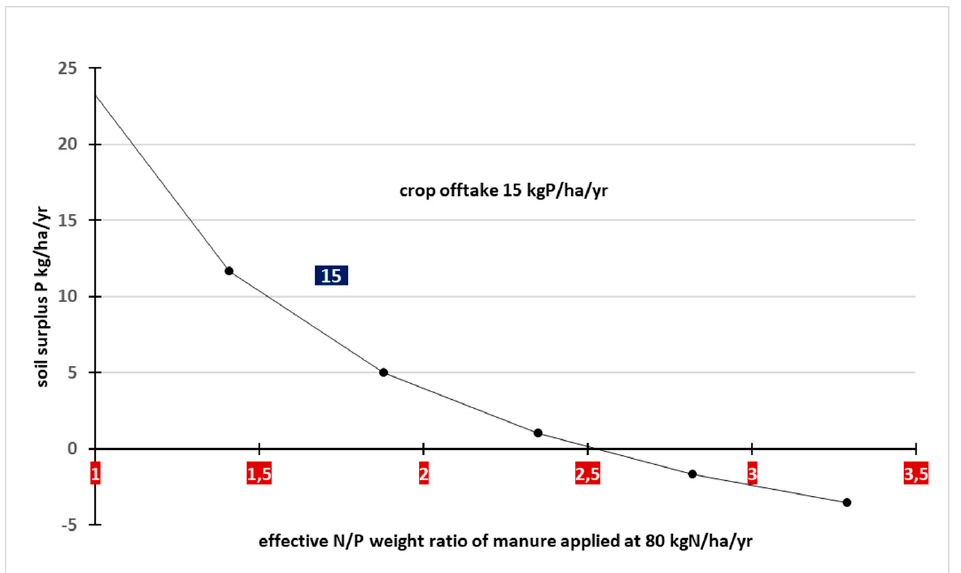
Figure 8. Graphic showing the relationship between the effective N/P ratio of manure applied at 80 kgN/ha/year and the resulting soil P surplus for crops at an offtake of 15 kgP/ha/year. A minus surplus represents “mining” of the P reserves in the soil.